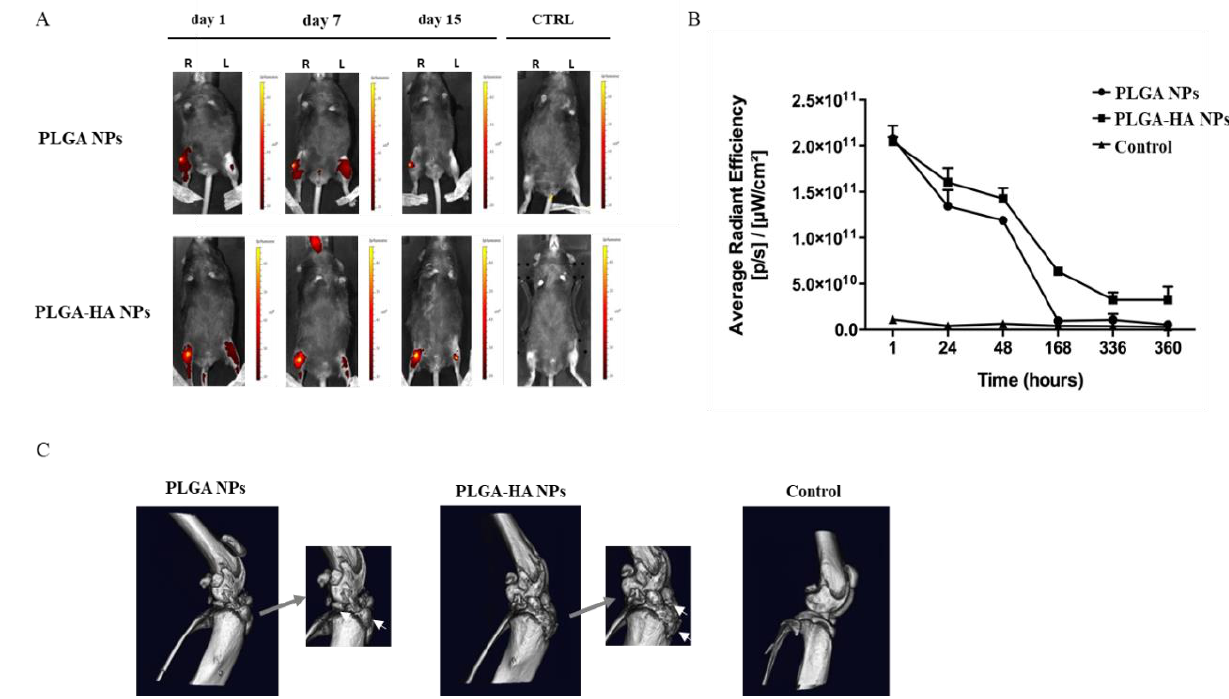
Figure 7. ( A ) In vivo retention of PLGA NPs and PLGA-HA NPs loaded with NIR dye for 15 days after IA injection in the right knee. The pictures depict a representative mouse for each NP treatment group at 3 different time points. From left to right, after 1, 7, and 15 days of NPs intra-articular injection. ( B ) The in vivo retention was measured as the average radiation intensity of each NP treatment over time, at 6 time points, in the OA knee. The control curve represents free dye injected intra-articularly and was used as a baseline comparison with the NPs. In vivo retention of PLGA NPs and PLGA-HA NPs loaded with gold and co-loaded with NIR dye followed for 15 days after IA injection in the right knee. ( C ) µCT scan of knee joints showing a 3D view of the bone surface. From left to right, representative pictures of knee treated with PLGA NPs, PLGA-HA NPs, and healthy knee (negative control) ( n = 3).